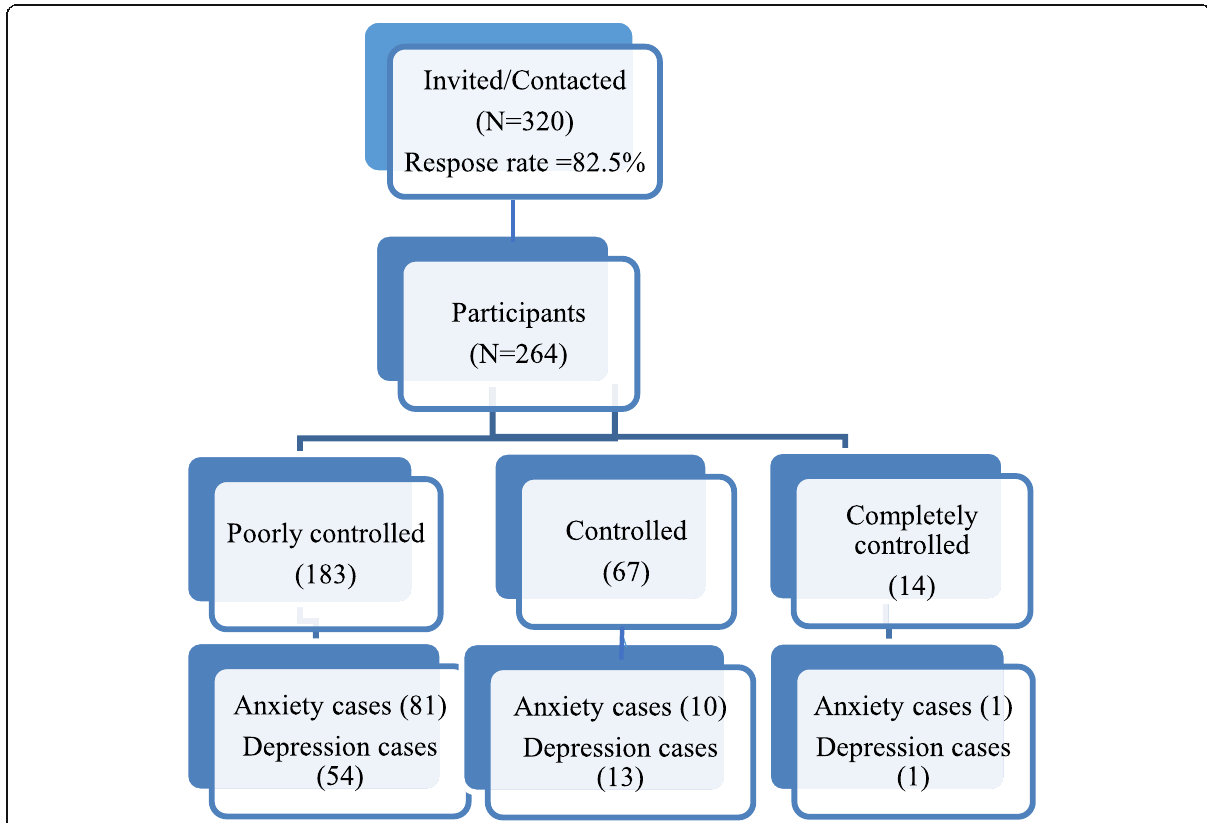
Fig. 1 Flowchart of study participants according to ACT and HADS